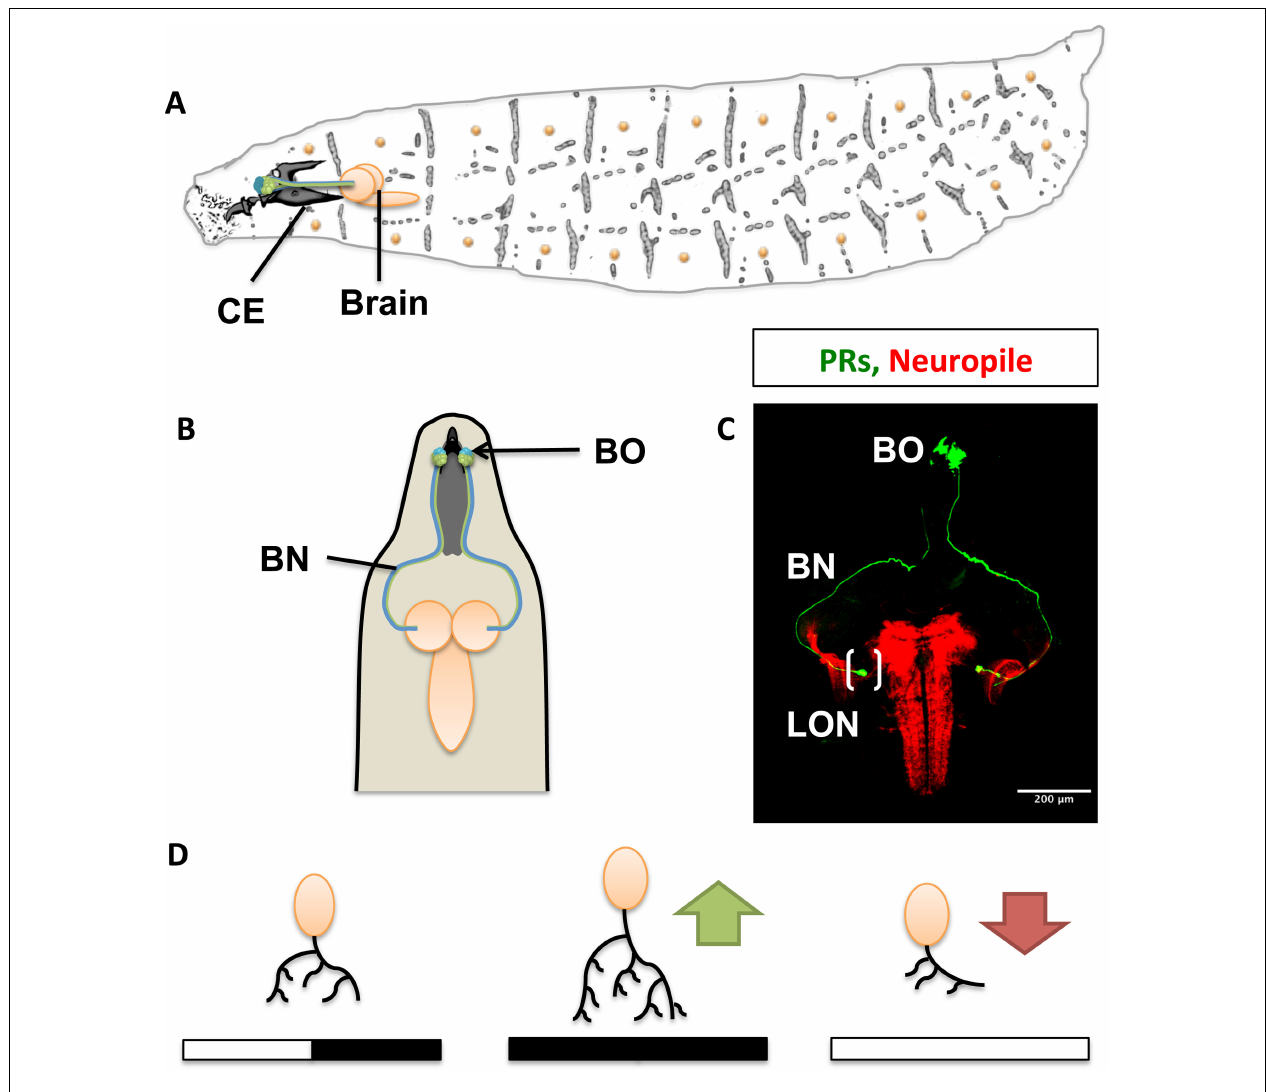
(LON) shown in brackets, the brain neuropiles are shown in red. (D) Light exposure effects on dendritic arbor length and activity. Constant darkness leads to increased arbor length and activity (green arrow) in contrast to exposure to 12 h of light and 12 h of darkness. Light hyperstimulation reduces dendritic arbor length and activity (red arrow) in a compensatory manner to high